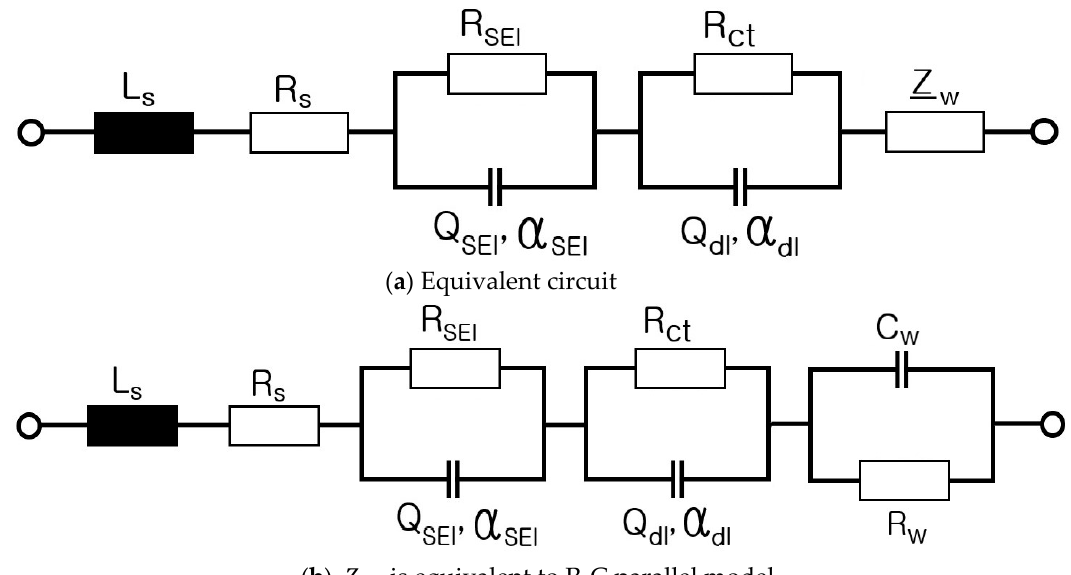
Figure 4. Complex plane diagram of the impedance spectrum of a cylindrical Li-ion battery [5,7]. In Figure 4, the small semicircle, which is expressed using the film resistance ( 𝑅 (cid:3020)(cid:3006)(cid:3010) ) and the capacitor ( 𝑄 (cid:3020)(cid:3006)(cid:3010) , 𝛼 (cid:3020)(cid:3006)(cid:3010) ), corresponds to the charge transfer of the solid electrolyte interface (SEI) generated by the inner electrode. The Warburg impedance ( 𝑍 (cid:3024) ), which is the diffusion region, denotes the diffusion of solid-state Li ions, and it increases with a slope of 45° in the complex plane [6,8]. 𝑍 (cid:3024) can be expressed as follows [8,9]: